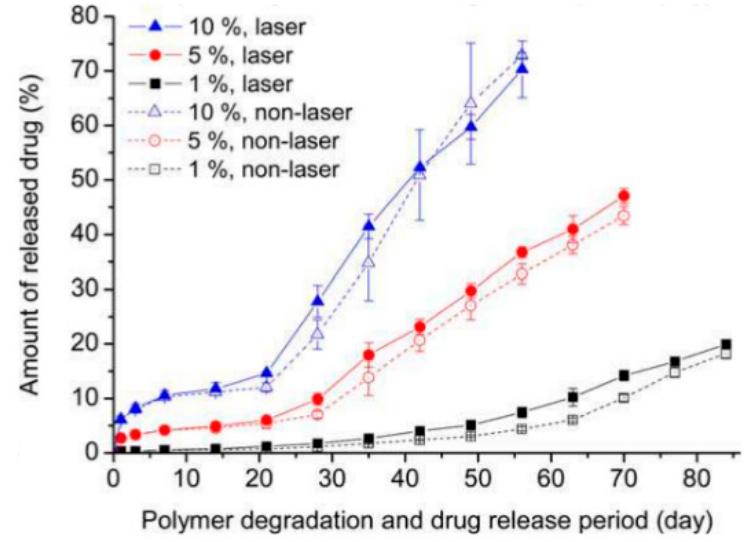
Figure 7. Drug release profiles of laser-treated and non-laser-treated matrices. Reproduced with permission from [63], [ACS Applied Materials & Interfaces]; published by [ACS Publications], [2016].